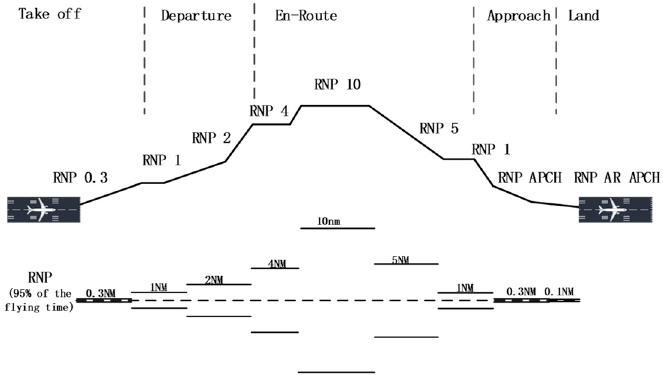
Figure 1. RNP for each